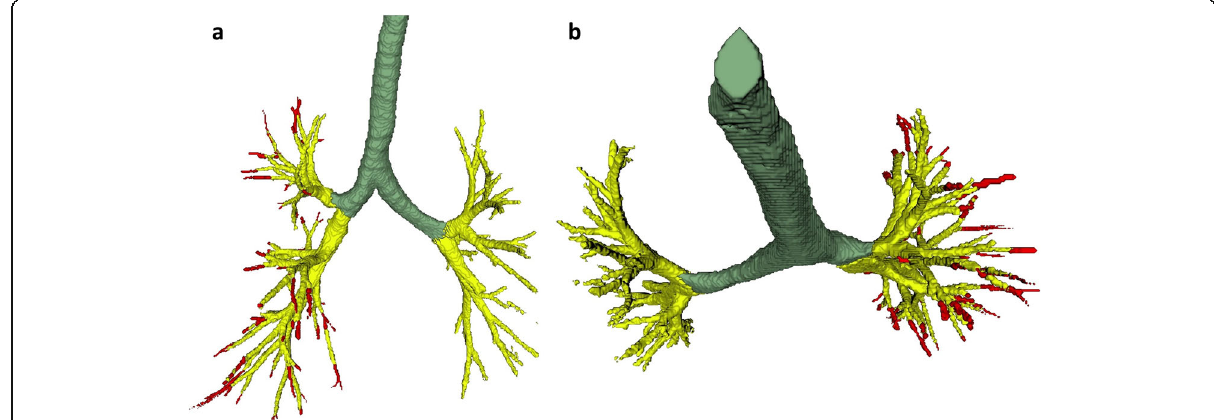
Fig. 2 An example of an incomplete segmentation of an ImaLife participant ’ s airway tree (in yellow) of the left lung and a manually corrected segmentation (in red) of the right lung